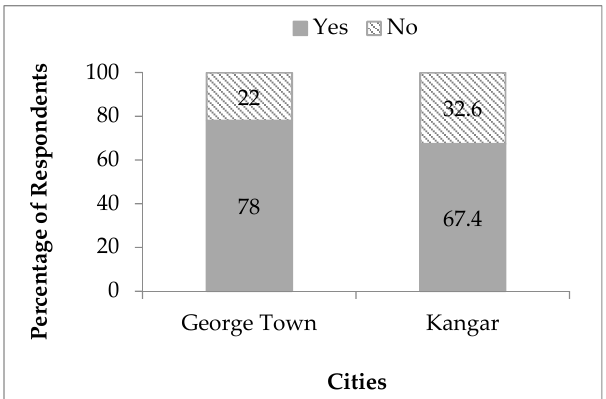
Figure 4. Self ‐ responsibility towards water loss issue. Figure 4. Self-responsibility towards water loss issue. Table 4. Public perception of the stakeholder’s responsibility in reducing water